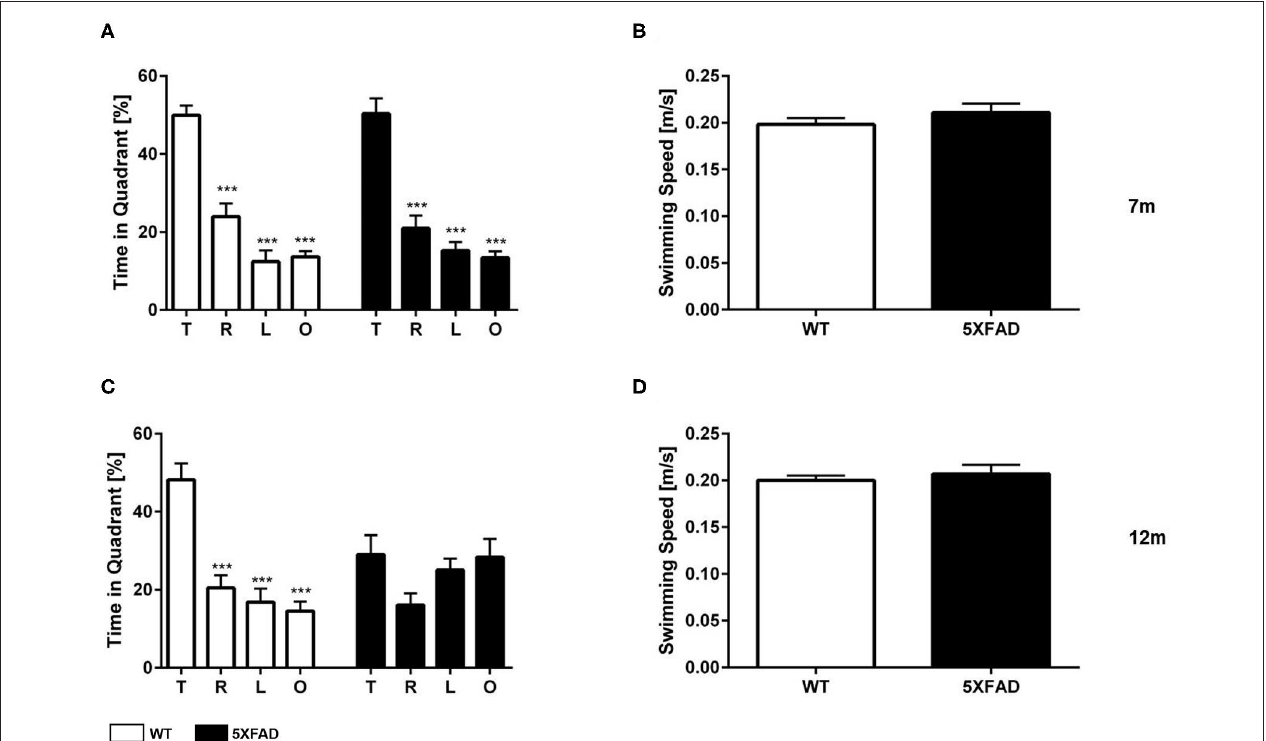
FIGURE 6 | Spatial reference memory deficits in 5XFAD mice in the Morris water maze. (A) 7-month-old WT and 5XFAD mice showed no memory deficits in the probe trial. (C) At 12 months of age male 5XFAD showed no quadrant preference revealing an impaired spatial reference memory. In contrast, 12-month-old WT animals displayed an intact reference memory. (B,D) Swimming speed was not altered at any of the tested time points. (A,C) One-way ANOVA followed by Bonferroni multiple comparisons. (B,D) Unpaired t -test; *** p < 0.0001; T , target quadrant; L , left quadrant; R , right quadrant; O , opposite quadrant; data presented as mean + /-